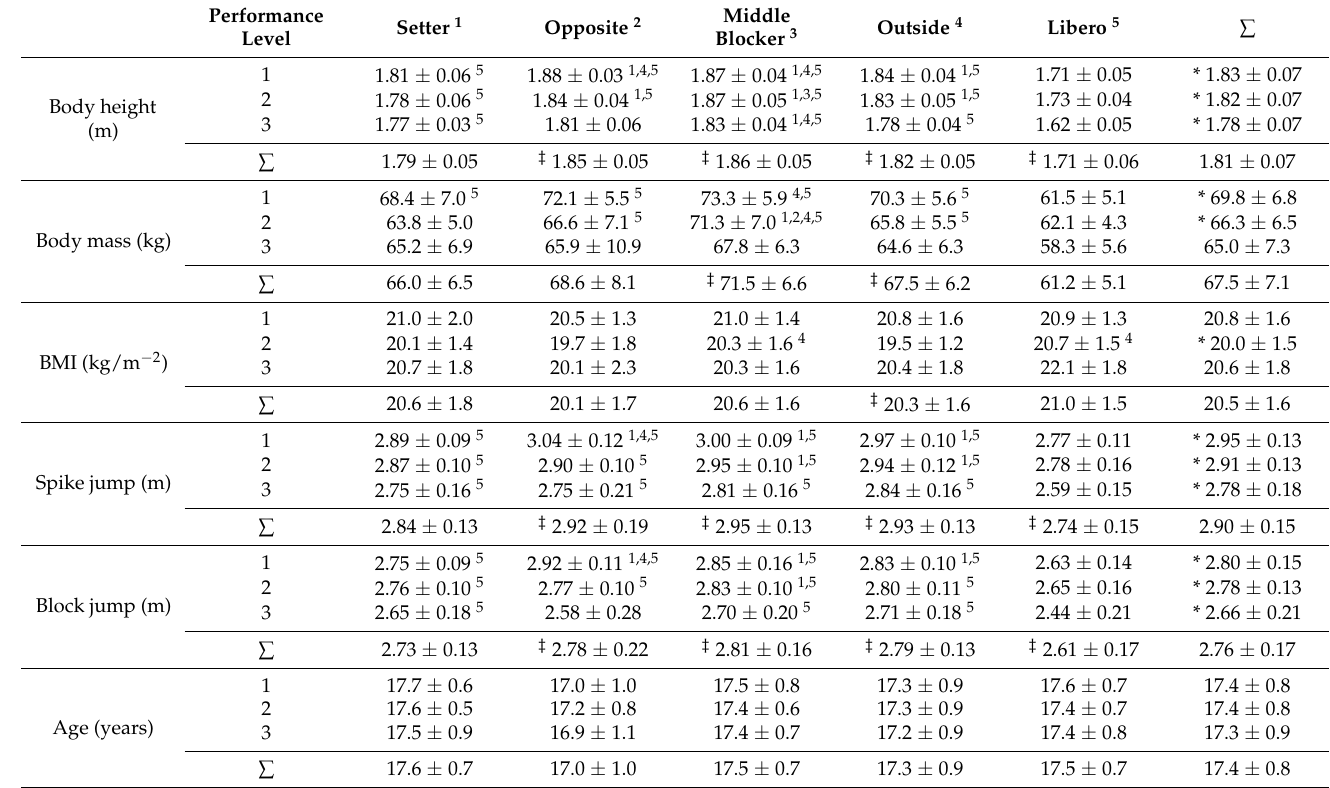
Table 2. Anthropometric, physical, and age characteristics of junior female volleyball players regarding position and performance